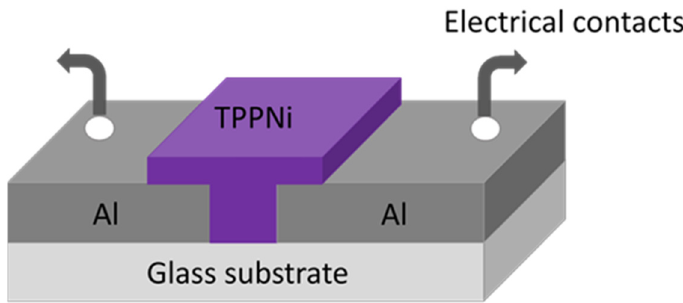
Figure 2. Schematic 3-D view of the Al/TPPNi/Al humidity sensor.